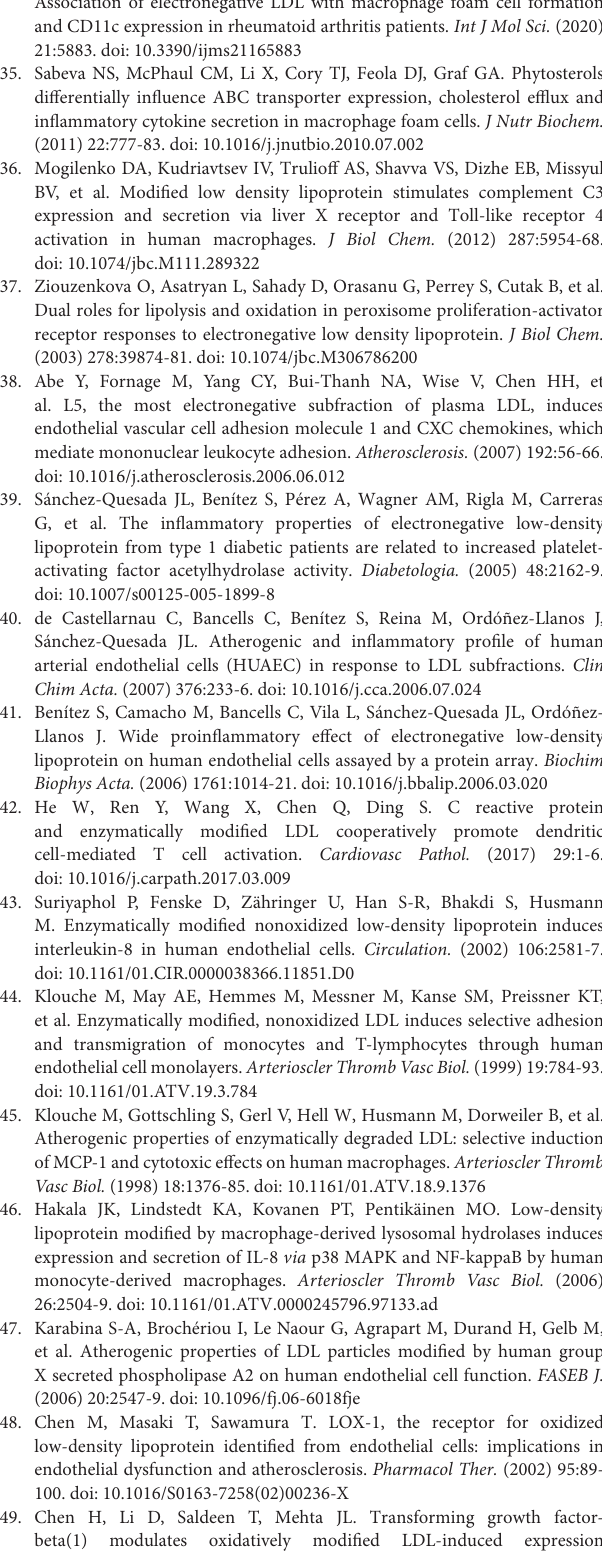
Frontiers in Cardiovascular Medicine |